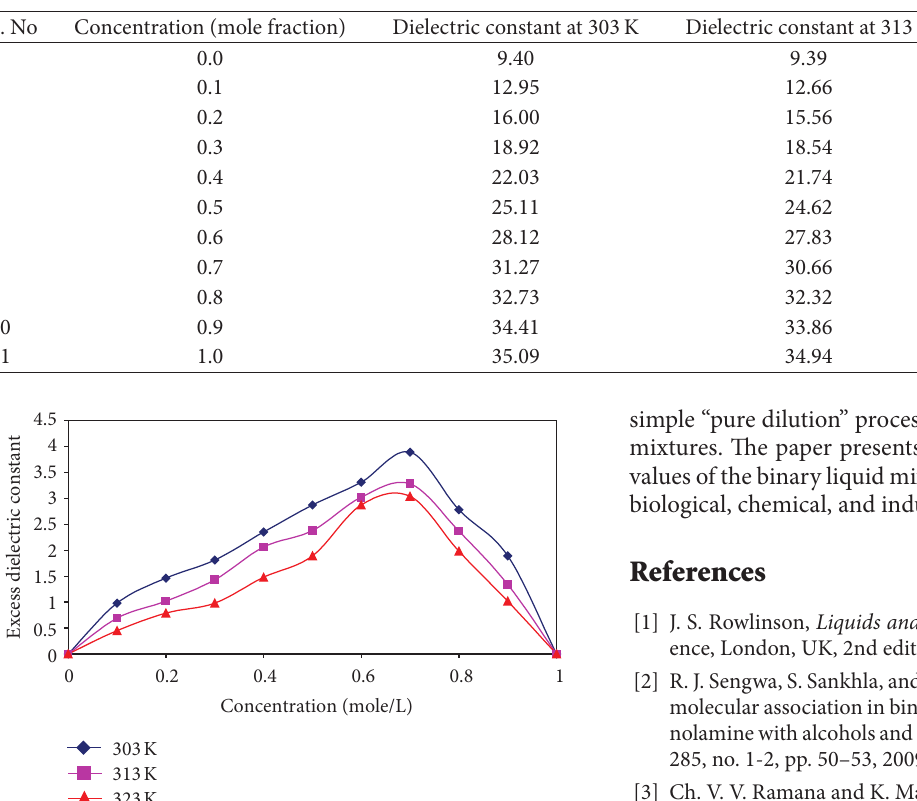
T 3: Dielectric constants for acetonitrile + methylamine mixture at 303, 313 and, 323K.